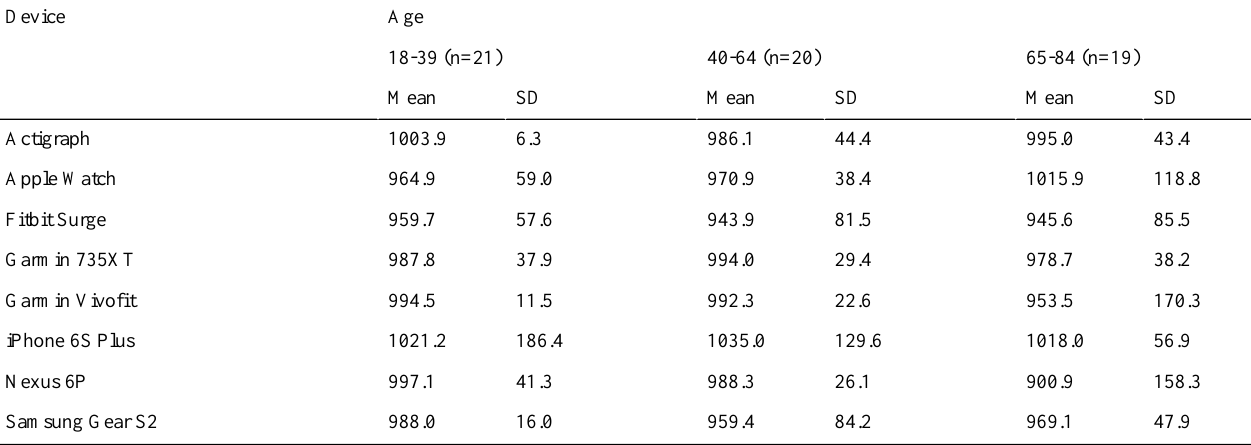
Table 2. Steps by device by age group (averaged across two measurements).